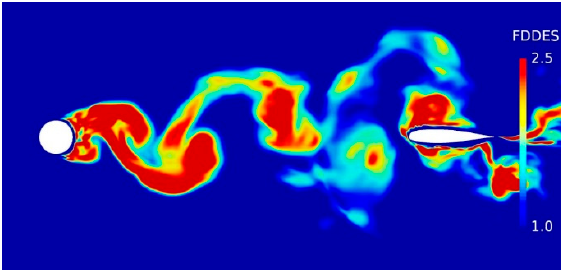
Figure 16. Instantaneous snapshot of blending function F DDES around airfoil in cylinder wake.